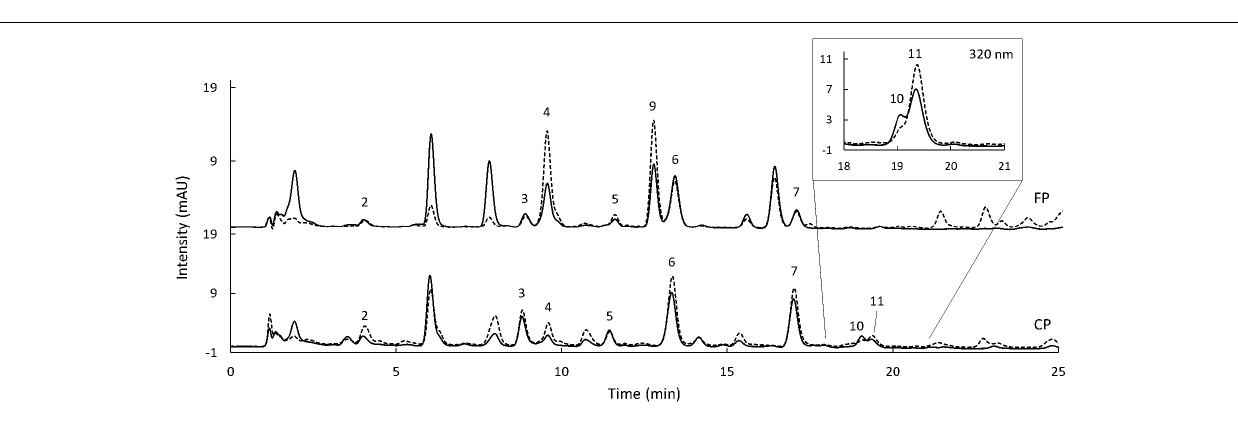
( Table 6 ). The red varieties, Armorik, Arsky, and Huggo, had the highest content of luteolinidin, between 18.69 and 32.69 µ g/g, which is the compound responsible for the red-orange color